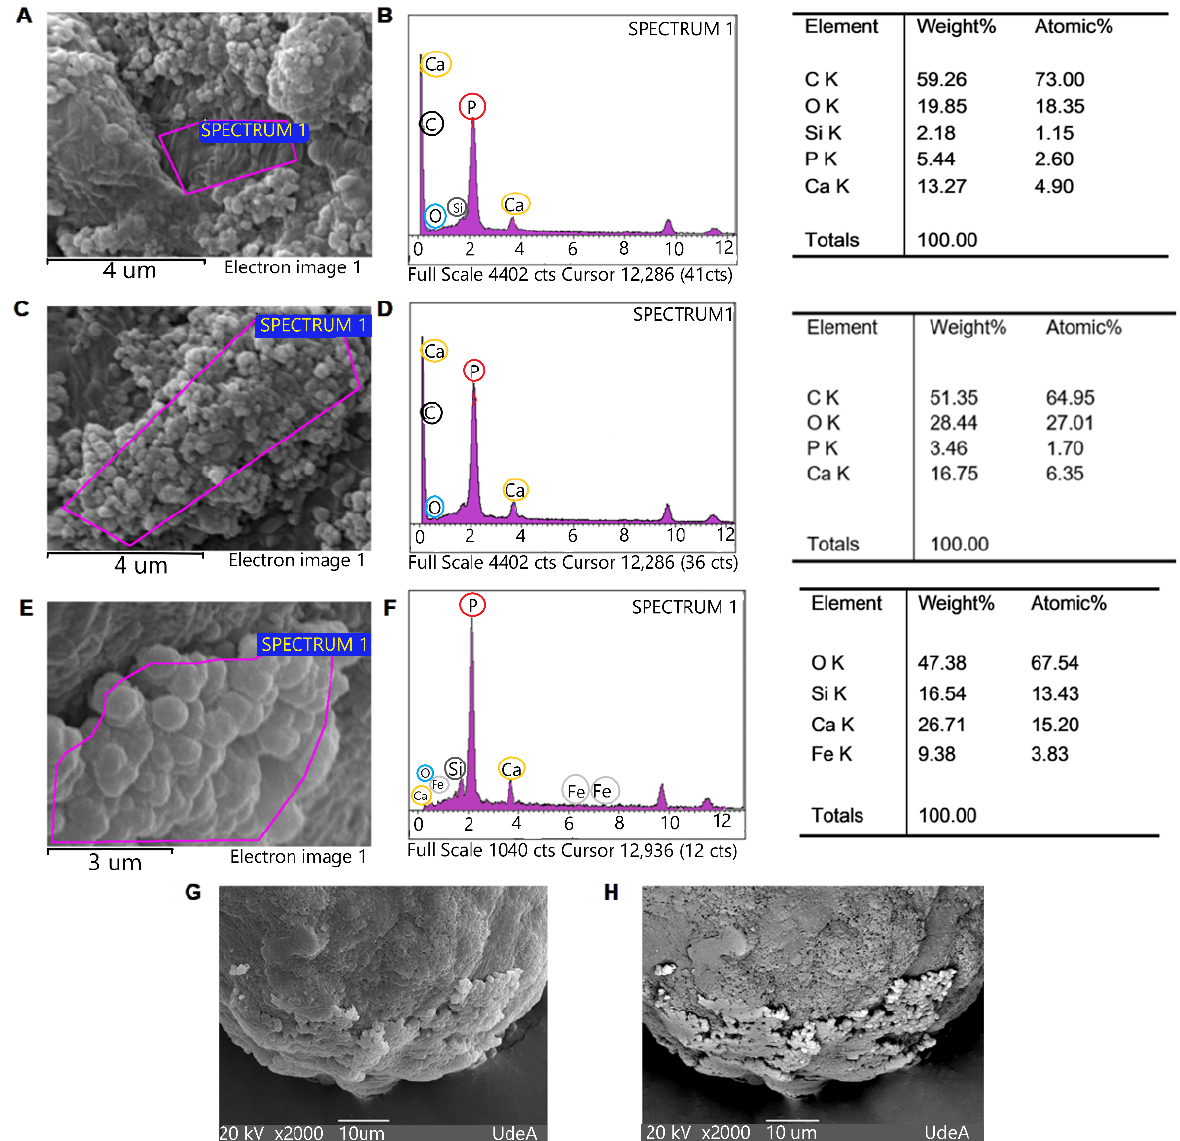
Figure 4. Ultrastructural analysis of the spheroidal surface of hGFs. ( A , C , E ) SEM images with the corresponding EDS spectrum and tables. ( B , D , F ) Detected ions (carbon (C), oxygen (O), phosphorus (P), calcium (Ca), and silica (Si)) in the purple area delimited in the SEM image of a spheroid. ( A , B ) Spheroid after 3 days of culture. ( C , D ). Spheroid after 21 days of culture. ( E , F ) Spheroid after 9 days of culture. ( G ) SEM and ( H ) EB images of a 9-day culture spheroid at lower magnification. Scanning electron microscope (SEM), spectrum of energy dispersive X-ray spectroscopy (EDS), and backscattered electrons